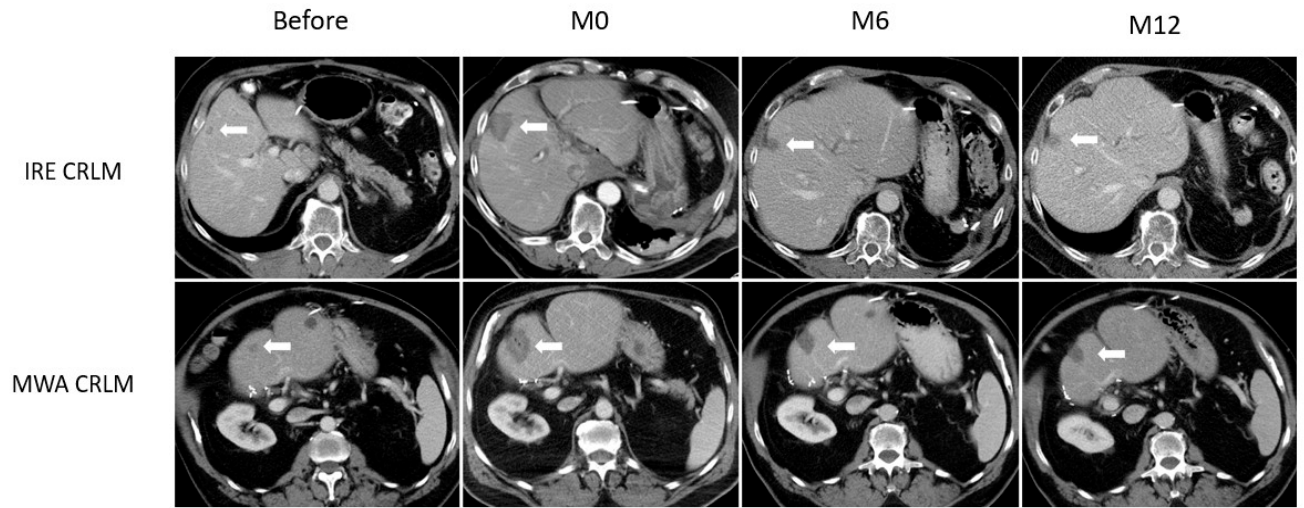
Figure 1. Example of ablation zone involution for CRLM. Axial CT slices showing 2 CRLM lesions (white arrow), both in segment IV, in a patient treated with IRE (upper row) and a patient treated with MWA (lower row). Lesions are shown before ablation, immediately after (M0), and at 6 (M6) and 12 months (M12) follow-up. In the CRLM subgroup, ablation surface area was significantly smaller at 6 and 12 months after IRE compared to MWA (Interaction p < 0.01).